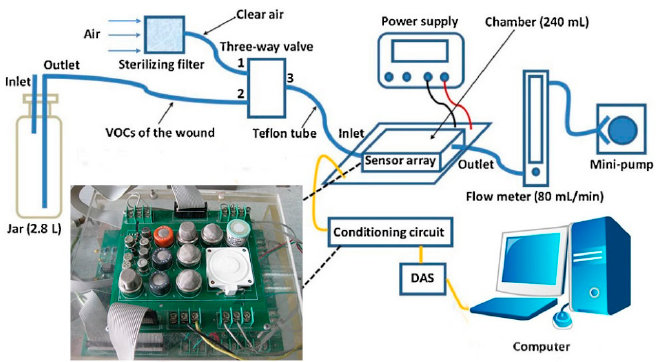
Figure 1. Schematic diagram of the experimental system.